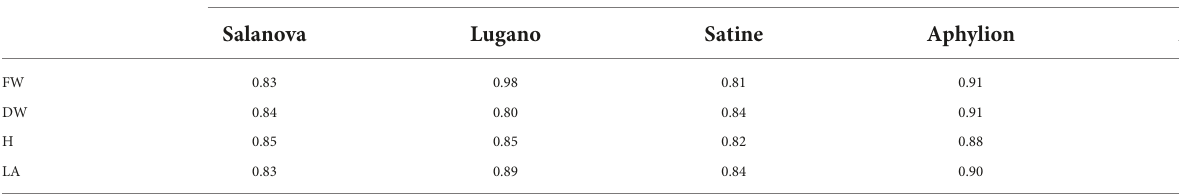
TABLE 4 Correlation between D and other traits of different lettuce varieties. Traits